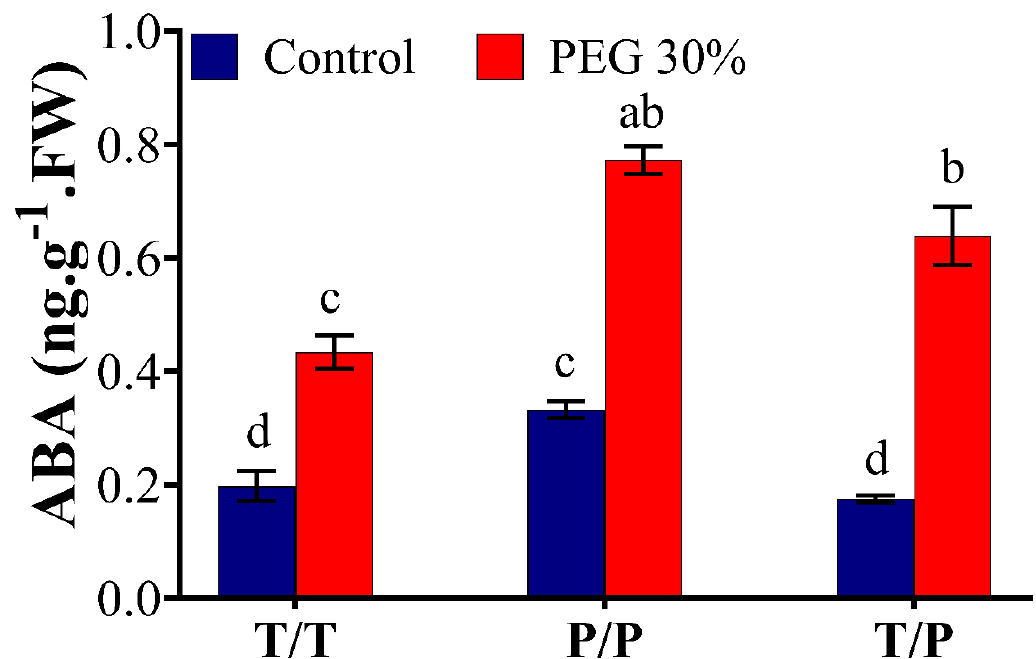
Figure 3. Quantification of ABA in potato and tomato plants. The homografted and heterografted plants were osmotically stressed by watering with 30% PEG. Leaves were collected at 24 h from the scion of homografted tomato (T/T), homografted potato (P/P) and heterografted (T/P) growing under untreated (control) and osmotic stress conditions. The bars represent the means ± SEM of three biological replicates. Different letters in each column indicate significant differences ( p ≤ 0.05) between treatments after Tukey’s test.